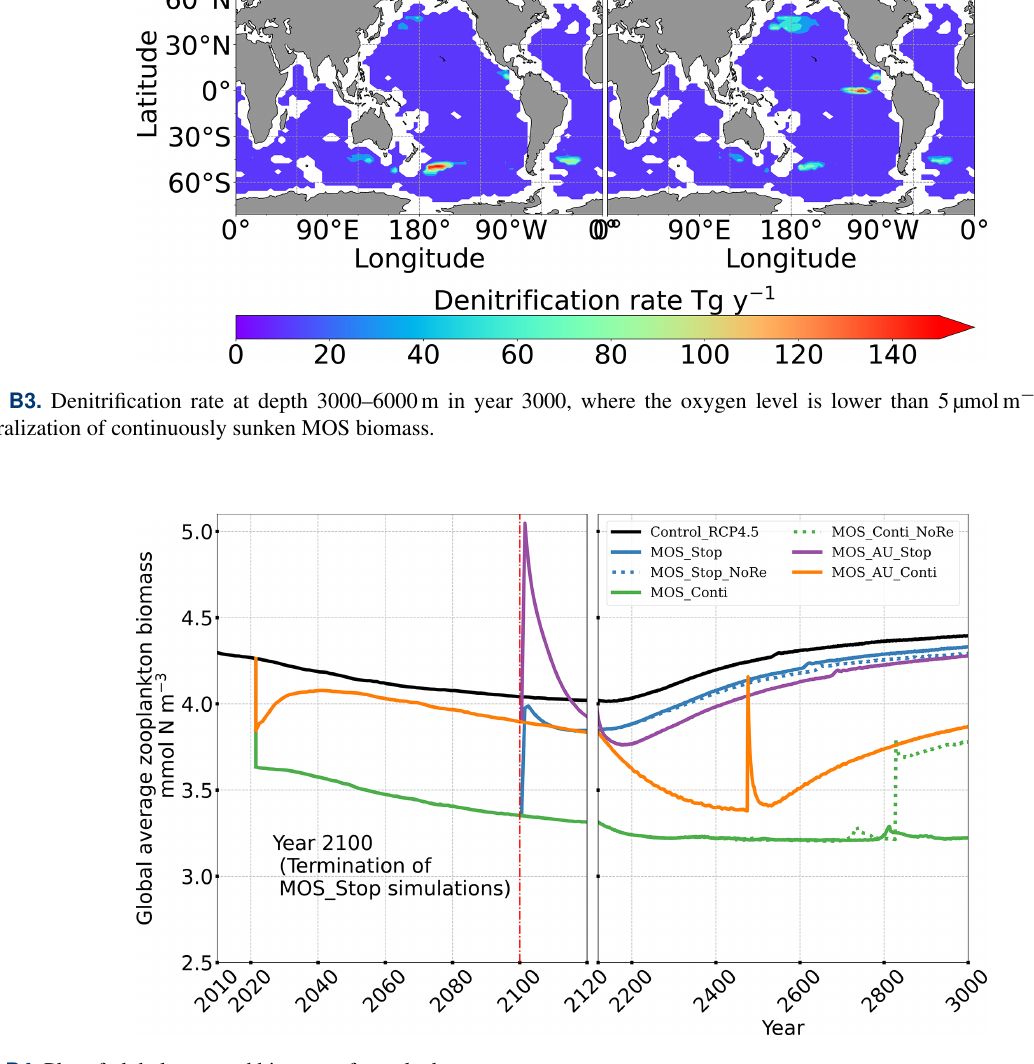
Earth Syst. Dynam., 14, 185–221, 2023